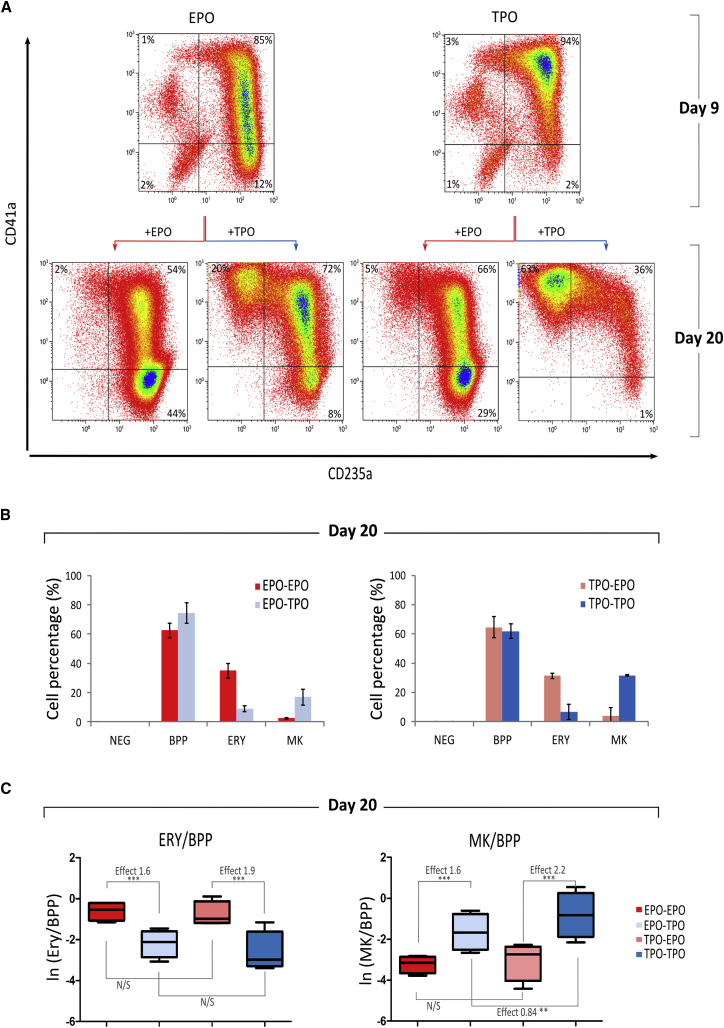
The impact of Cytokines Used in the Early and Late Phases of Culture on Erythroid and MK DifferentiationCells were FoP in EPO or TPO until day 9 (early phase) and then maintained in the same medium or switched to the other cytokine condition for the second phase (days 9–20). The impact on MK and ERY differentiation was monitored by flow cytometry at days 9 and 20.(A) Representative flow cytometry dot plots for CD41a and CD235a expression on days 9 and 20 of FoP following culture regimens indicated by arrows.(B) Percentages of cells at day 20 belonging to the NEG (CD41−/CD235−), BPP (CD41+/CD235+), ERY (CD41-/CD235+), and MK (CD41+/CD235−) populations, respectively (n = 4, mean ± SEM).(C) Boxplots over sets of four replicates of the log(e) of the number of ERYs (left plot) and MKs (right plot) over the number of BPPs as detected by flow cytometry at day 20, broken down by cytokine exposure at days 9 and 20. The mean effect of TPO used between days 9 and 20 on a cell being an MK rather than BPP was similar (2.2 and 1.6) for cells cultured in TPO and EPO between days 2 and 9, respectively (∗∗∗p < 0.001). The mean effect of EPO used between days 9 and 20 on a cell being an ERY rather than BPP was similar too (1.9 and 1.6) for each of the condition used between days 2 and 9, respectively (∗∗∗p < 0.001). By contrast, conditional on the second cytokine, the effect of the cytokine used between days 2 and 9 on the MK/BPP and ERY/BPP were not significant in three of the four comparisons and below one for the fourth.